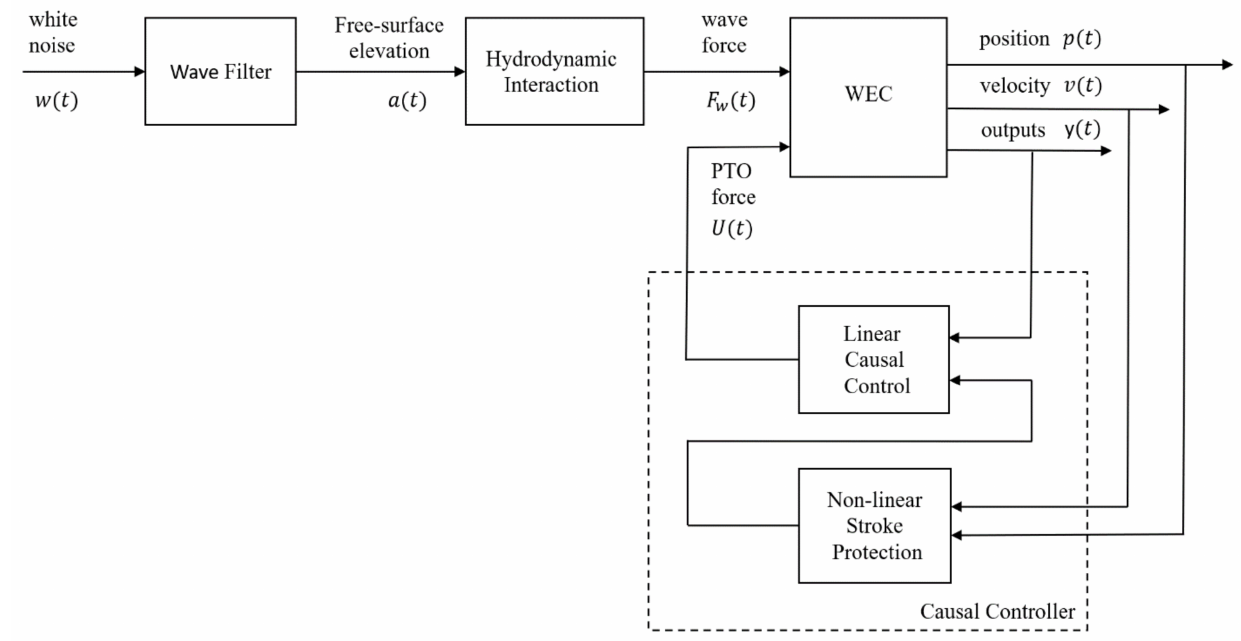
Figure 1. Architecture of causal